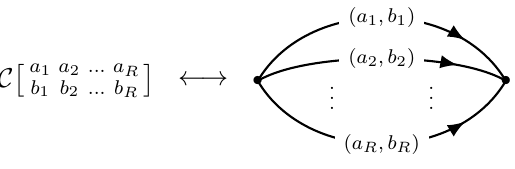
Figure 1 . Dihedral graph with decorated edges and notation for modular graph